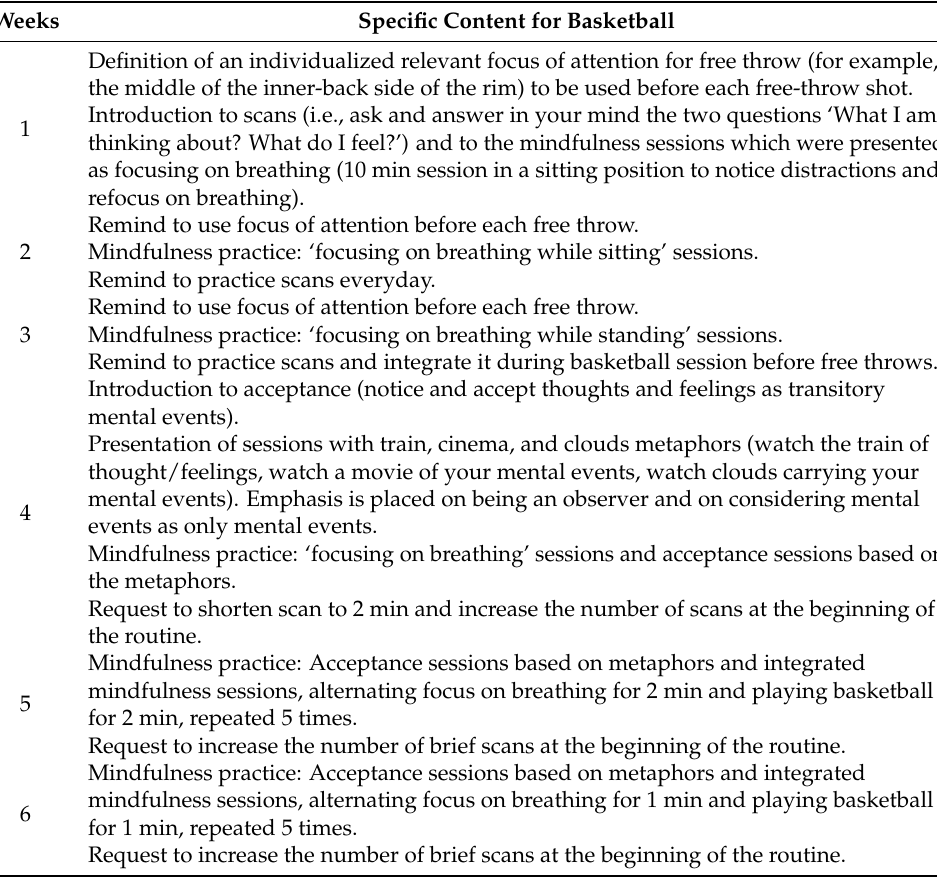
Table 1. Adapted content of the six-week MFP programme in